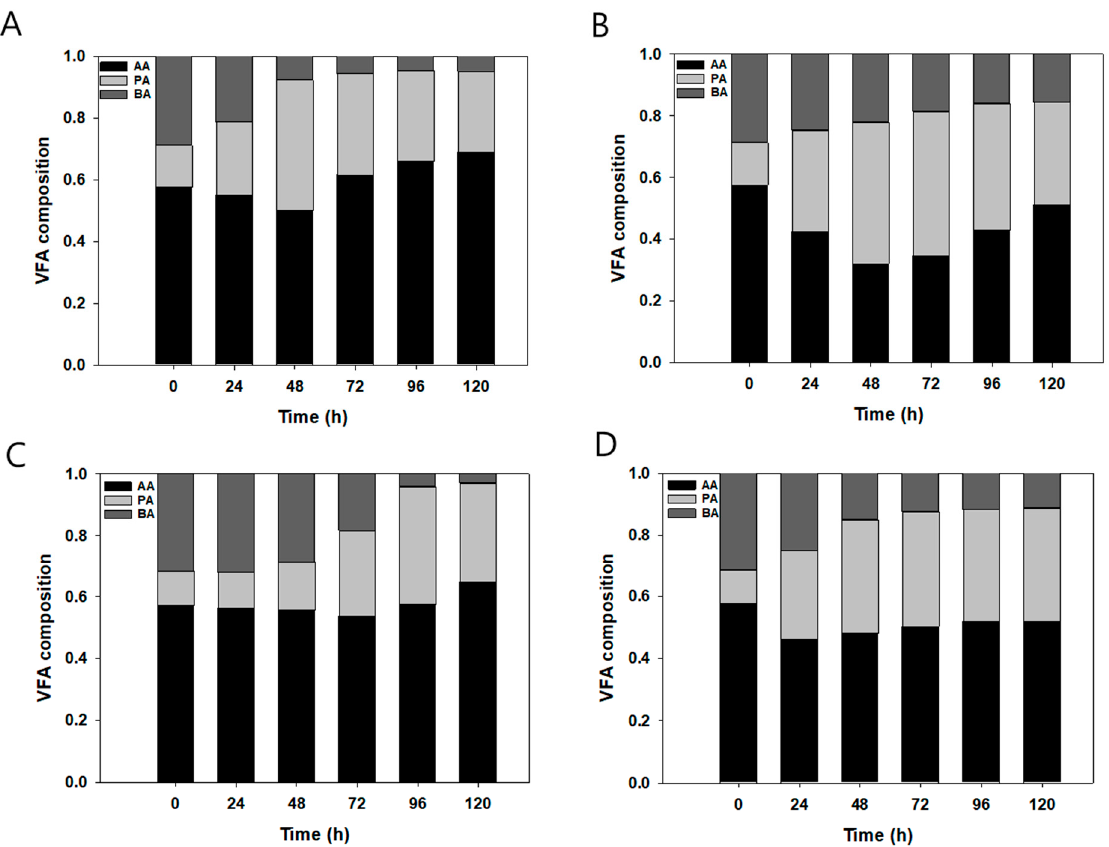
Figure 5. VFA composition under each condition (initial VFA composition was 60% AA, 10% PA, and 30% BA): ( A ) 2 g/L and pH 5.5, ( B ) 2 g/L and pH 7.0, ( C ) 5 g/L and pH 5.5, and ( D ) 5 g/L and pH 7.0. VFA solutions were fed manually after 63 h in order to maintain the concentration at 2 g/L and pH 5.5. Table 3. Fatty acid profile and consumed VFA of C. curvatus from automatic fed-batch cultivation.